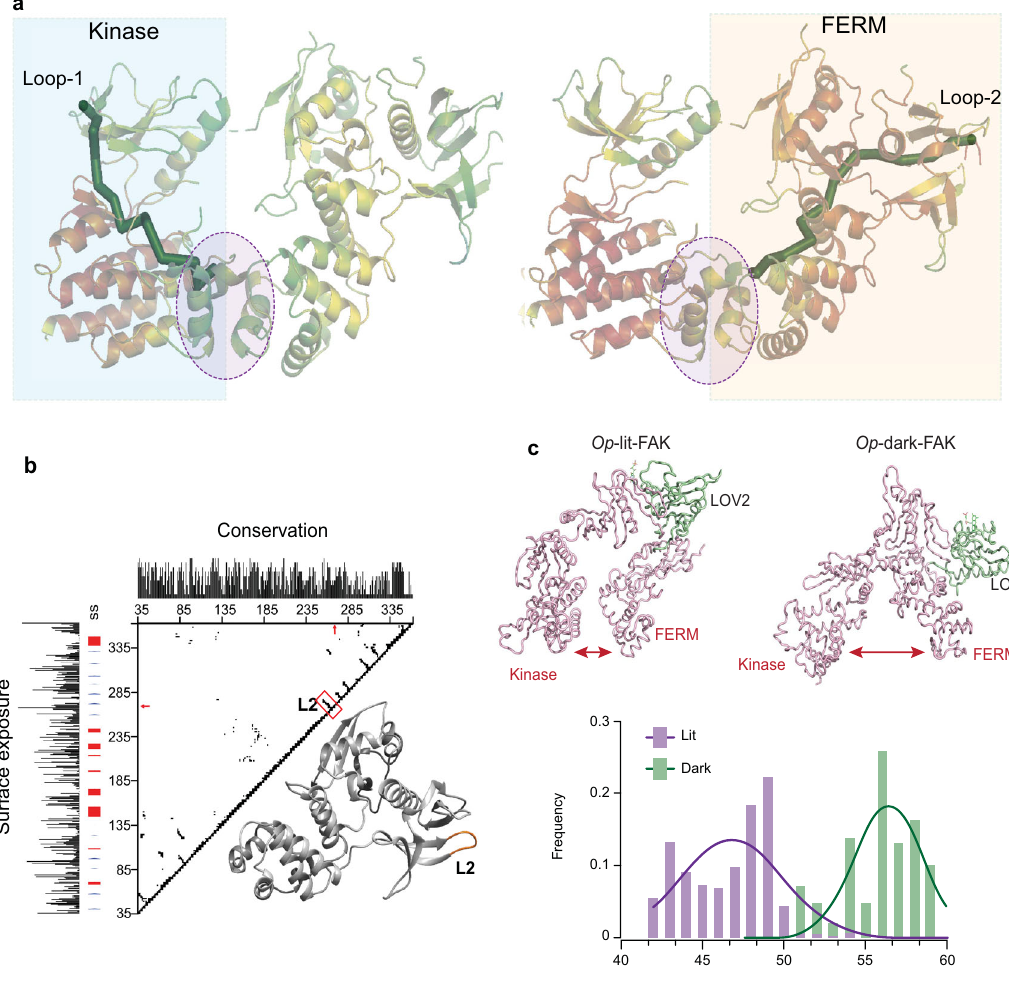
Fig. 5 Computational identi fi cation of insertion site and DMD simulations. a Ribbon diagrams of FAK from the published crystal structure (PDB ID: 2JOJ). Loop 1 is the insertion site for uniRapR (left), and Loop 2 is the insertion site for LOV2 (bottom). Green paths represent signal propagation pathways from the insertion sites to the target region (circled). b Contact map computed from the published crystal structure (PDB ID: 2JOJ) for sequence conservation and surface exposure. Loop 2 (L2) has low sequence conservation and high surface exposure. Bottom fi gure demonstrates the β -hairpin loop (loop 2) within the FERM domain. c Top, snapshots from the DMD simulations showing conformations of Op -lit-FAK and Op -dark-FAK. The distance between the two domains in Op -dark-FAK is indicative of activation. Bottom, frequencies of structures with given distances between FERM and kinase domains in Op -lit- FAK and Op -dark-FAK quanti fi ed during DMD simulations. Source data are provided as a Source Data